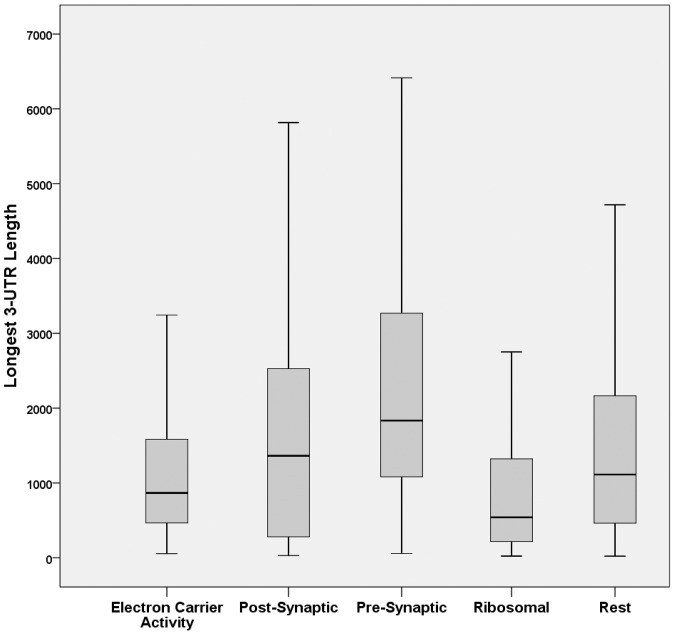
Comparative analysis of longest 3′UTR sequences from synaptic and non-synaptic control transcript groups.Boxplots depicting 3′UTR length of the electron-carrier activity, postsynaptic, presynaptic, ribosomal and rest protein-coding transcripts with the longest 3′UTR sequence.